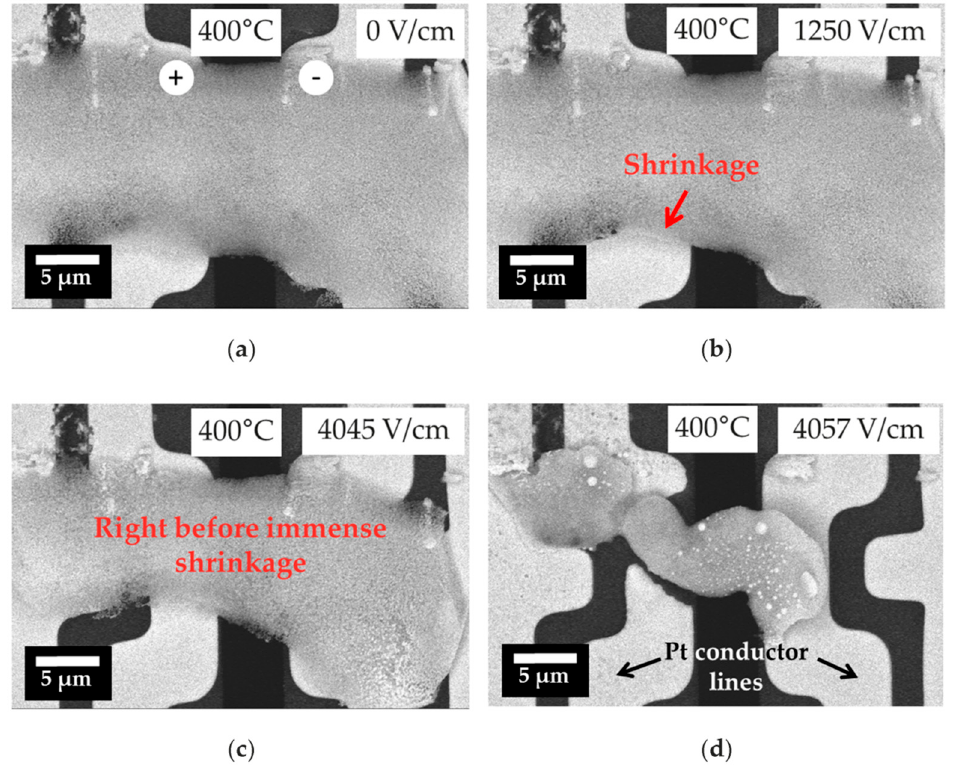
Figure 7. ZnO green body shrinkage in SEM. ( a ) The green body is stable at 400 °C, ( b – d ) but shrinks and forms precipitates under an applied field and current, and ( d ) eventually reacts with a Pt-conductor line. EDX mapping obtained from the middle area of the ZnO lamella (Figure 8a–c) confirms that the precipitates are Pt-rich and Zn-poor. In contrast to the observations in TEM, the ratio of the